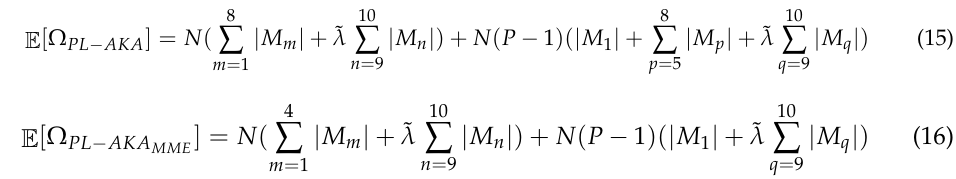
Table 1, | M 1 | = | M 2 | = 176, | M 3 | = 608 U + L , | M 4 | = | M 5 | = | M 6 | = | M 7 | = | M 8 | = L , | M | = 288, and | M | = 64. The signaling overhead of the PL-AKA depends on L and λ 9 10 determined by P ◦ and P ◦ M F